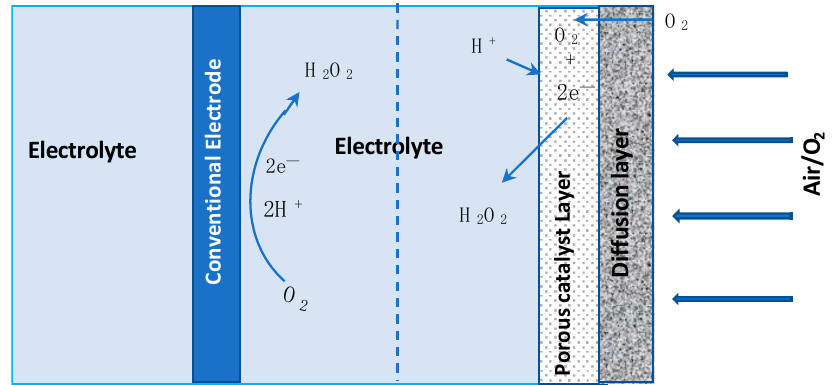
Figure 4. Schematic diagram of conventional solid-state electrode and porous gas diffusion electrode where the solid catalyst layer coexists with gas and liquid phases. Table 2. Summary of porosity and H 2 O 2 generation rate for various porous graphene-based composites.